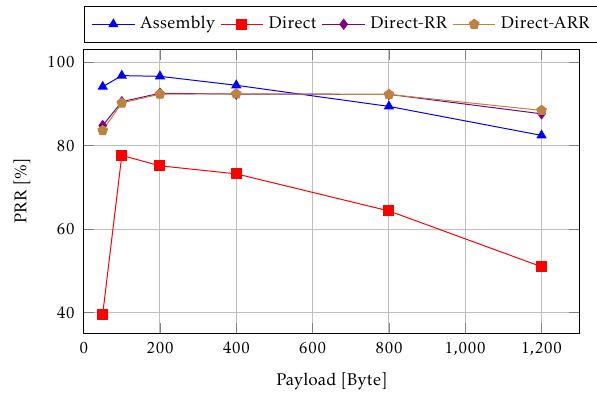
Figure 6. PRR of the LongY Network 37 . 5 B/s ; first set of